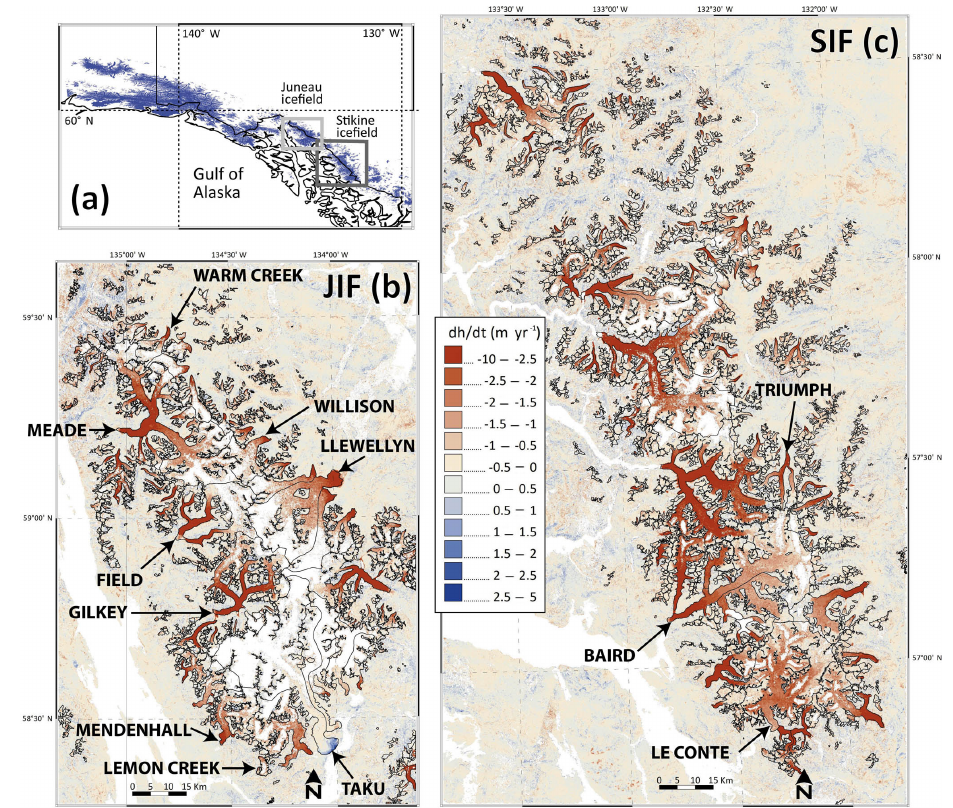
Figure 1. Rate of elevation changes for the Juneau and Stikine icefields from 2000 to 2016. (a) Location of the two icefields in southeast Alaska. Rate of elevation changes (d h/ d t ) for the JIF (b) and for the SIF (c) . Glacier outlines are from RGI v5.0. Glaciers surveyed by airborne laser altimetry are labeled. The horizontal scale and the color code are the same for the two maps. Areas in white correspond to data